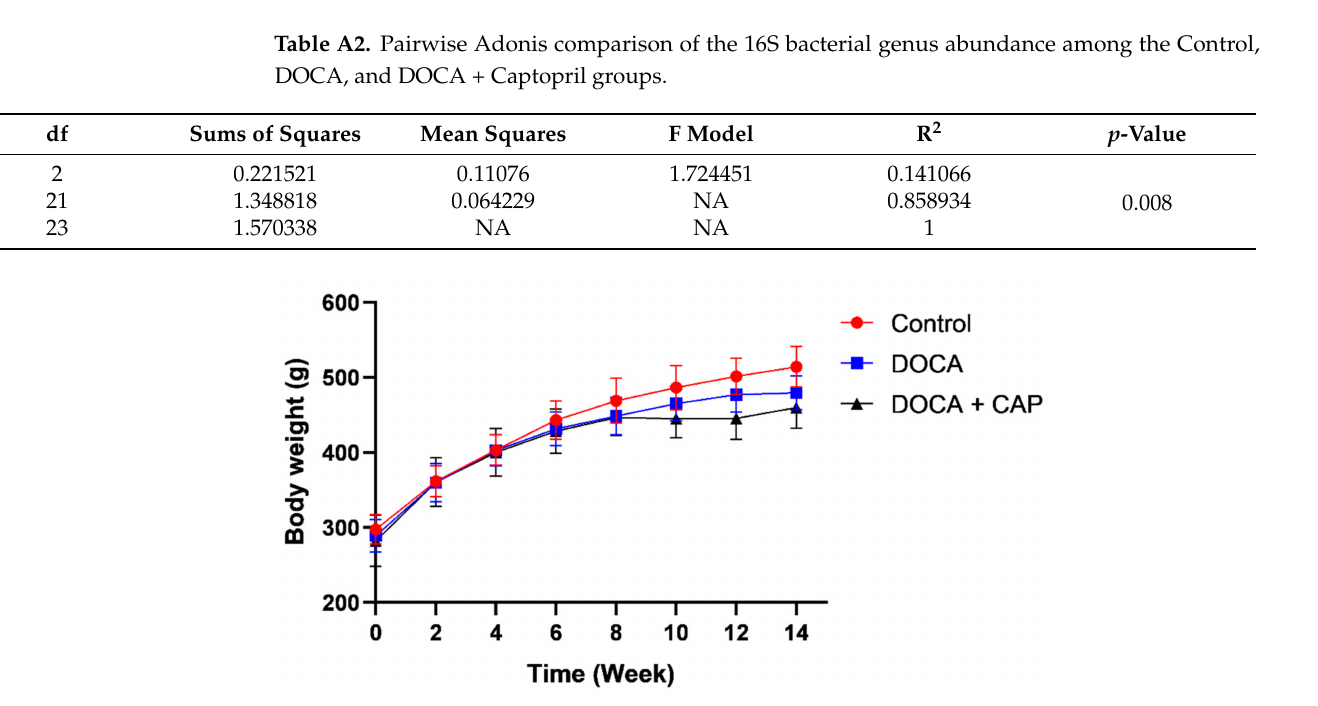
Figure A1. Average body weights of the rats of the control, DOCA-induced hypertensive, and captopril-treated groups from weeks 0 to 14.